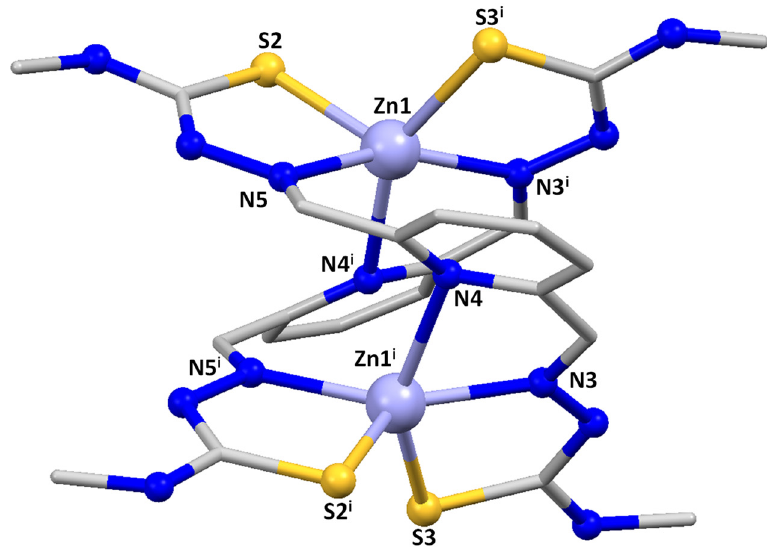
Figure 1. Crystal structure of the zinc helicate [Zn 2 (L Me ) 2 ] · 3H 2 O 1* . Solvent molecules were omitted for clarity.